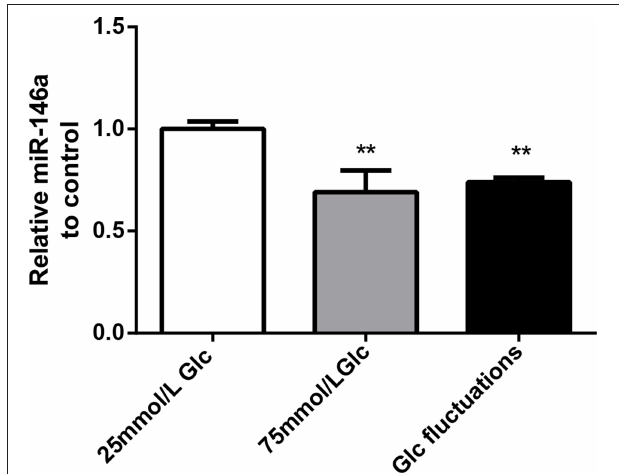
FIGURE 1 | Effects of high glucose and glucose fluctuations on miR-146a levels in BV-2 cells. Expression levels of miR-146a, ** p < 0.01 75 mmol/L Glc vs. control, ** p < 0.01 Glc fluctuation vs.